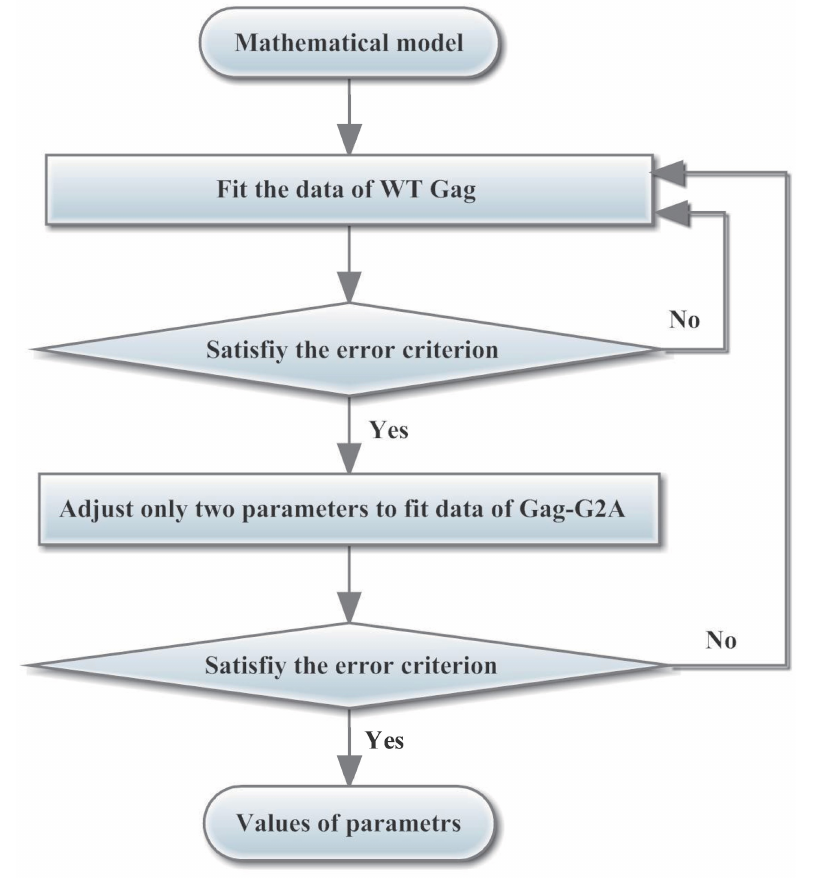
Fig 3. The flow chart of the parameter